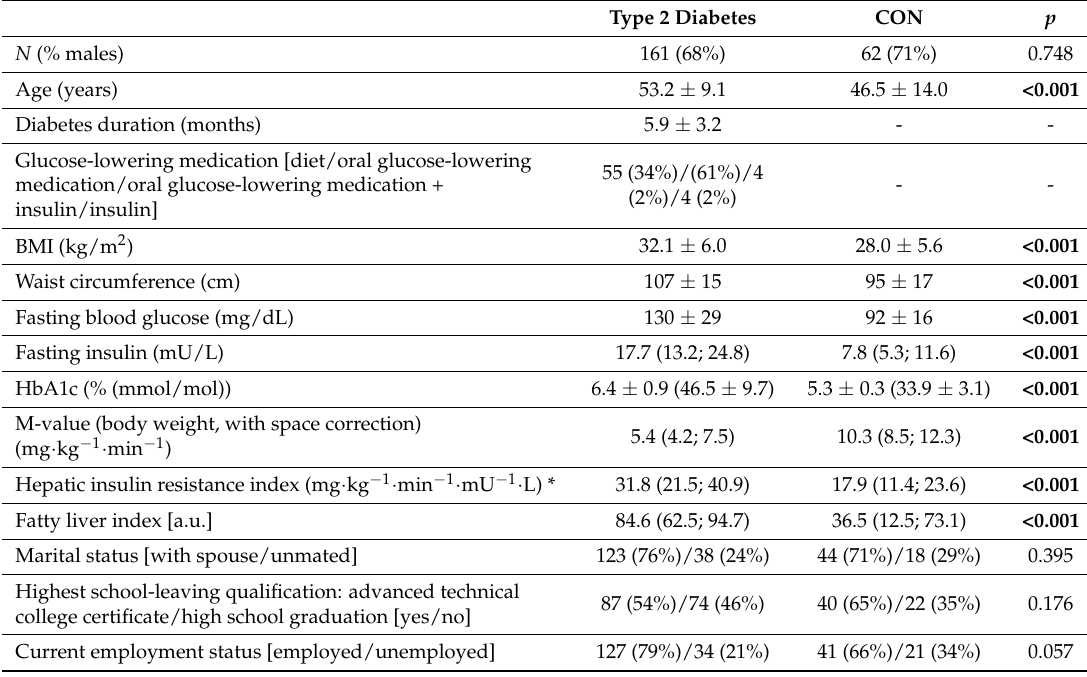
Table 1. Characteristics of patients with type 2 diabetes and individuals without diabetes.